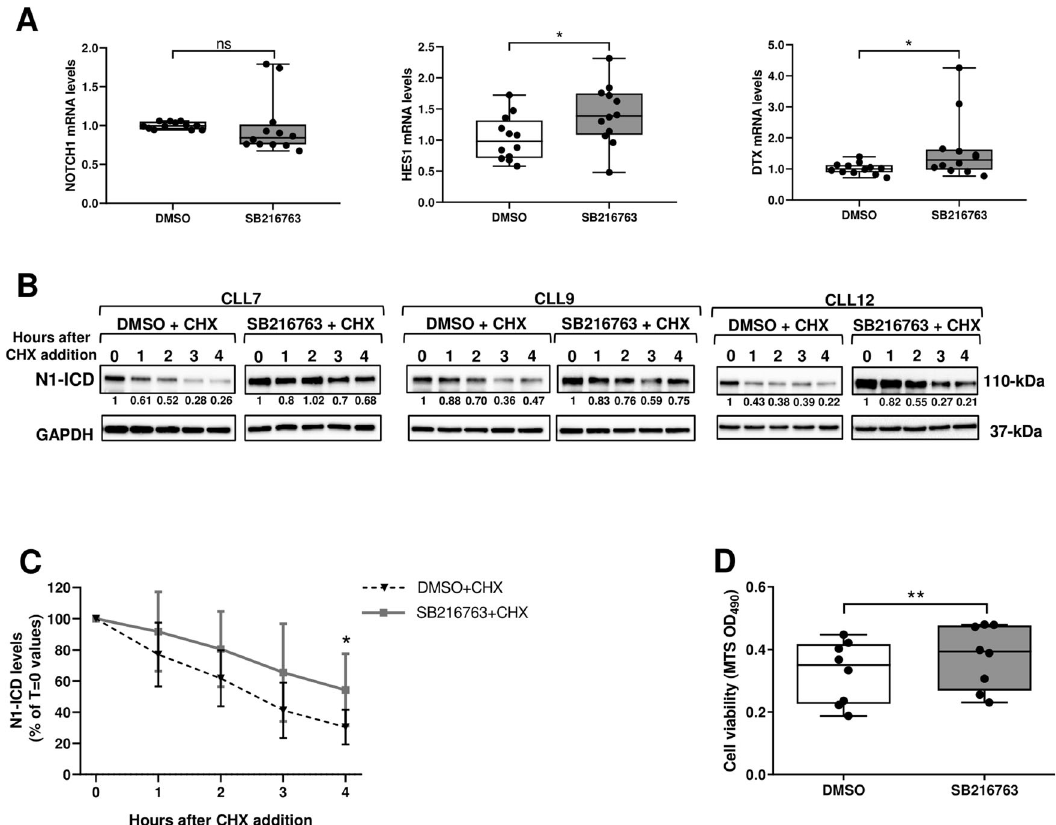
Fig. 2 Pharmacologic GSK3 β inhibition enhances N1-ICD stability and CLL cell viability. A Box and whisker plots with data points of real- time PCR analysis of NOTCH1, HES1 and DELTEX (DTX) mRNA in CLL cells cultured for 3 h with 5 μ M SB216763 or DMSO as control ( n = 12). mRNA levels were normalized to GAPDH and represented as fold change using control cells as a reference. * P < 0.05; ns, not signi fi cant, according to Wilcoxon paired test. B , C After pretreatment with 5 μ M SB216763 or DMSO for 1.5 h, CLL cells were treated ( T = 0) with 50 μ g/ml CHX and harvested at the indicated times for Western blot analysis of N1-ICD and GAPDH, as a loading control ( n = 6). B The values under the blots relative to each treatment indicate the fold change in N1-ICD expression at the different time points compared with the respective T = 0 (set to 1), normalized to GAPDH levels. Three CLL samples are shown. C N1-ICD bands were quanti fi ed by densitometry analysis, normalized to GAPDH and represented as percentage of T = 0 value set to 100%. Data are presented as the mean ± SD of 6 CLL samples. * P < 0.05 according to Wilcoxon paired test. D CLL cells were cultured for 18 h with 5 μ M SB216763 or DMSO as control ( n = 8). Cell viability was measured by MTS assay. Box and whisker plots with data points, expressed as optical density (OD) values, are shown. ** P < 0.01 according to Wilcoxon paired